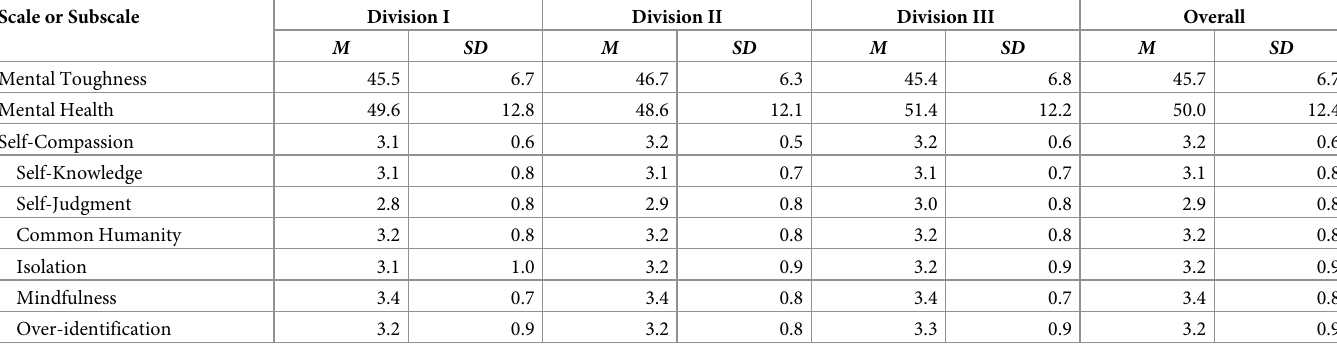
Table 3. Descriptive statistics of all scales and subscales by NCAA division. Scale or